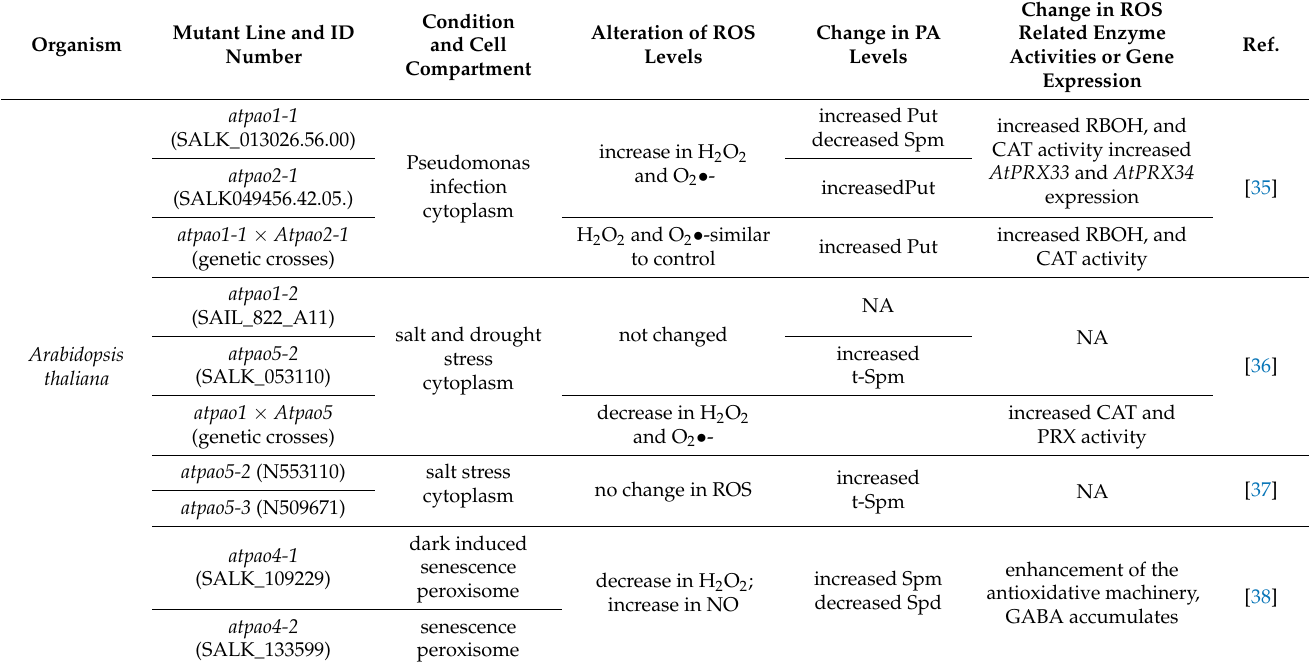
Table 1. Mutations in plant polyamine oxidase-coding genes affecting reactive oxygen species homeostasis and polyamine levels under various experimental conditions. The cell compartements where the mutations prevented the accumulation of the given polyamine oxidases are